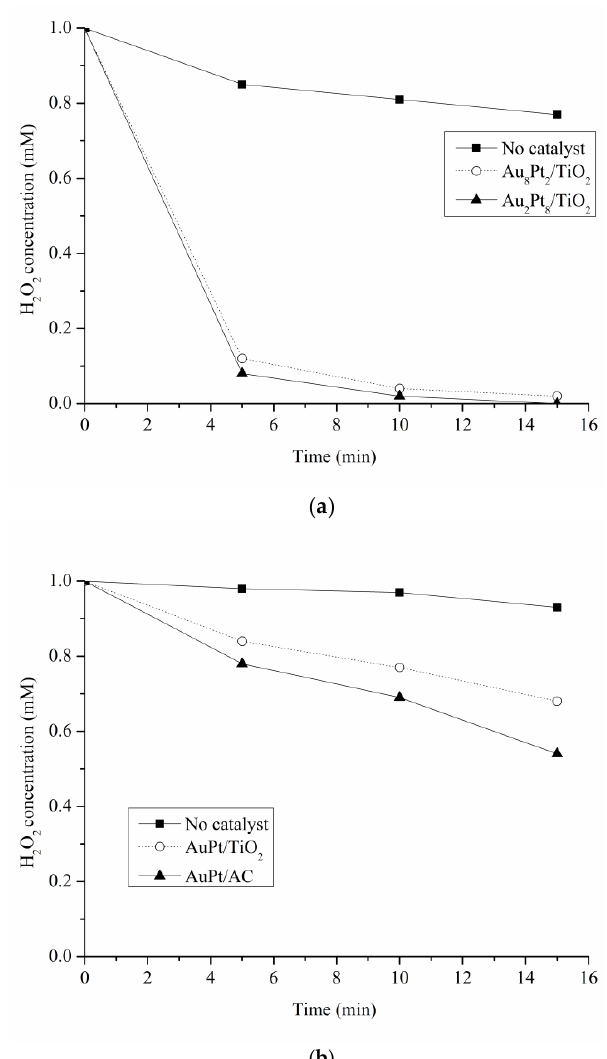
Figure 7. H 2 O 2 decomposition at ( a ) 80 °C pH > 14 or ( b ) 80 °C and pH 3.